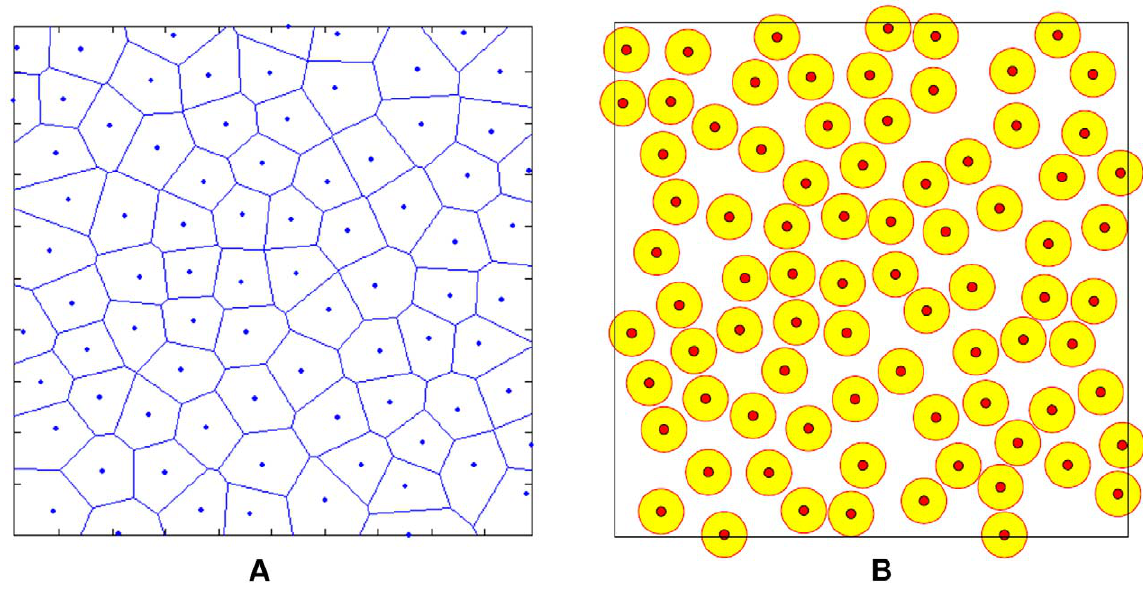
Figure 2. A 2D Voronoi tessellation and the associated point configuration. (a) A Voronoi tessellation of the 2D plane into polygons which are the automaton cells in our model. (b) The associated point configuration for the tessellation, generated by randomly placing nonoverlap circular disks in a prescribed region, i.e., the random sequential addition process [34].